Question: Write a caption explaining this figure to a reader.
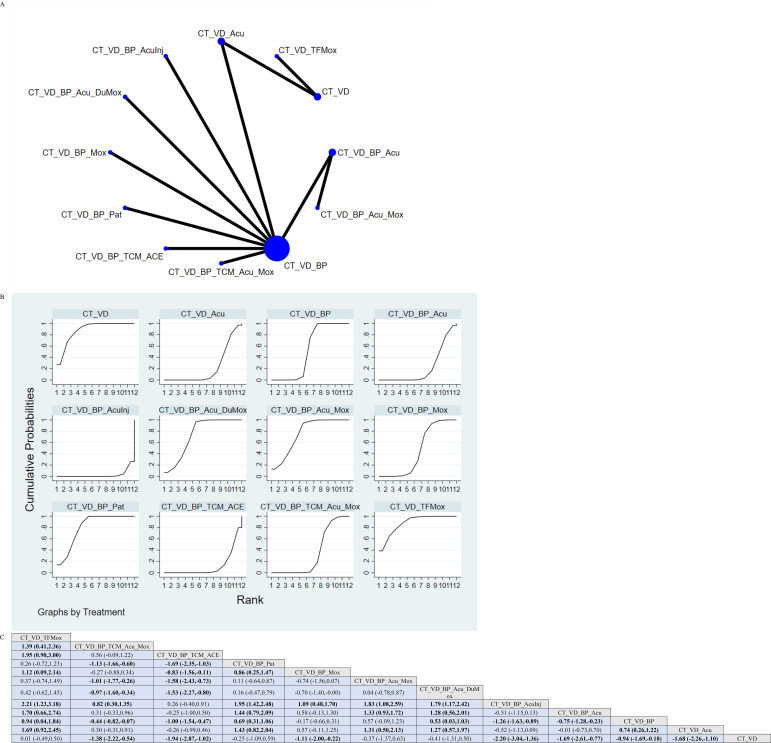
Answer: Network meta-analysis of PINP (A) Network plot of the network meta-analysis for PINP. (B) Rankogram of overall intervention strategies from the network meta-analysis for PINP. (C) League table of the network meta-analysis for PINP.